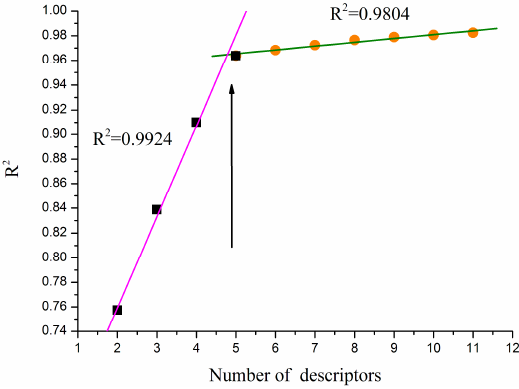
Figure 2. The “breaking point” rule results. Table 2. Fungicidal activity and structural descriptors of the title compounds.